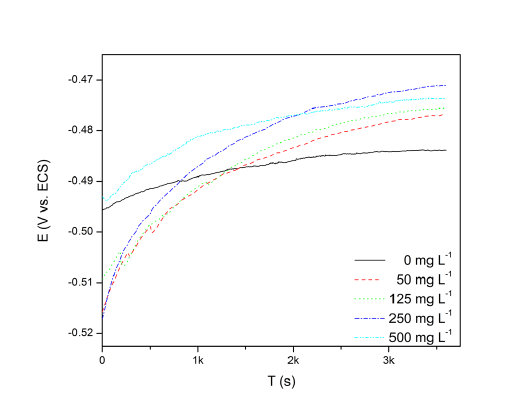
Figure 2: Open circuit potential (OCP) of C‑steel in 1.0 mol·L -1 H